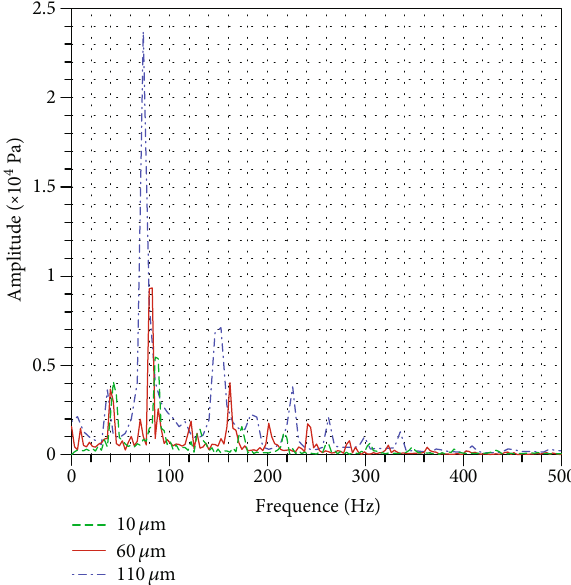
Figure 15: Spectrogram plots of the pressure trace at P3 for di ff erent initial LOX particle diameters shown in Figure